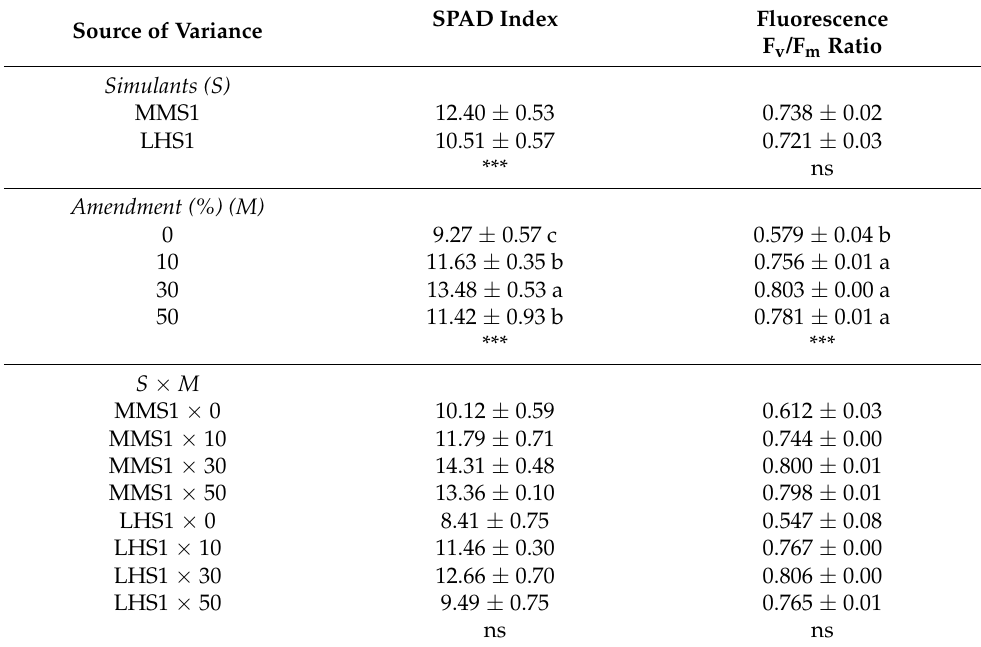
Table 3. SPAD index and fluorescence in different mixtures of MMS-1 or LHS-1 simulants and manure (simulant/manure rates: 100:0, 90:10, 70:30, 50:50; w / w ). SPAD Source of Variance